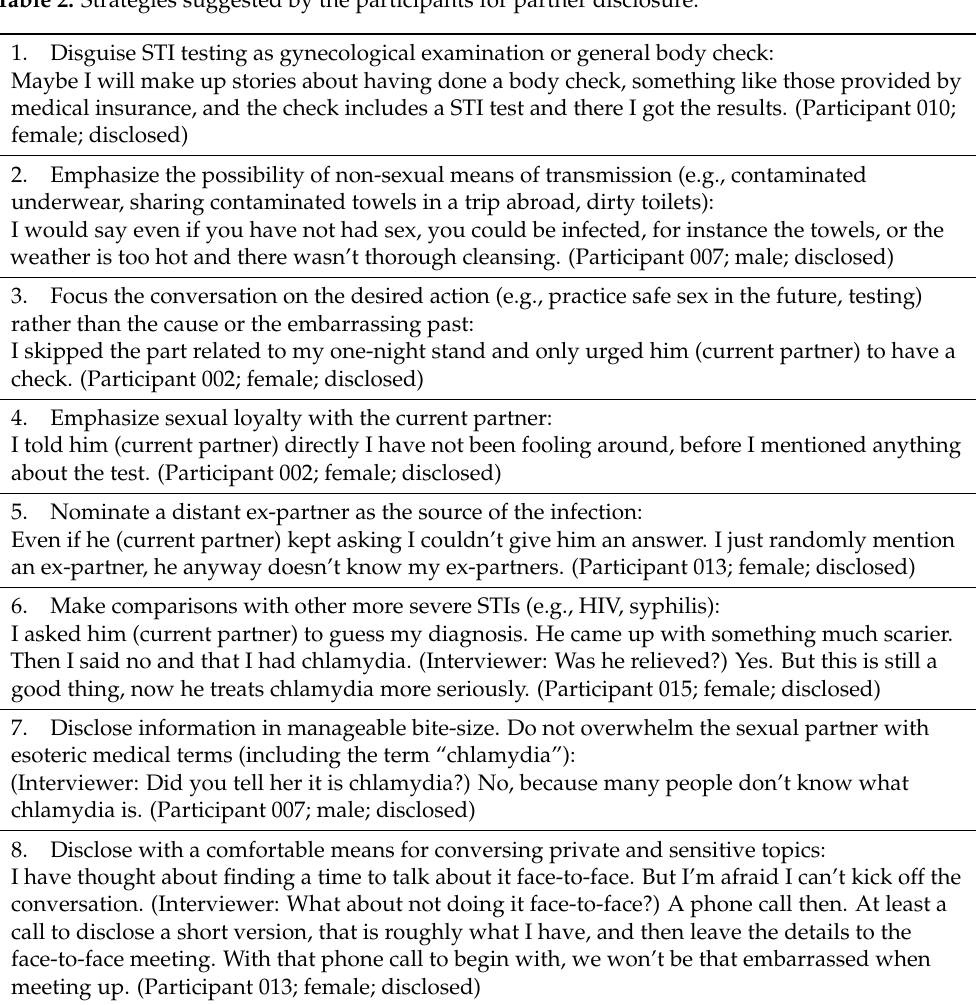
Table 2. Strategies suggested by the participants for partner